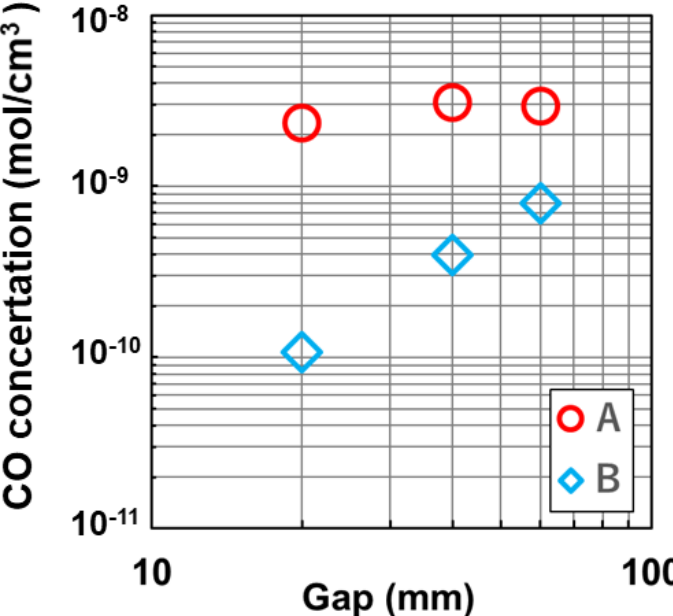
Figure 7. Measured CO concentration as a function of gap width between the melt surface and thermal shield. Reproduced with permission from Y. Miyamura, H. Harada, X. Liu, S. Nakano, S. Nishizawa, K. Kakimoto, Journal of Crystal Growth; published by Elsevier, 2019 [8]. The heat shield (no. 5) shown in Figure 3 is another source of CO generation. Some crystal growers coated the shield by SiC to prevent the generation of CO